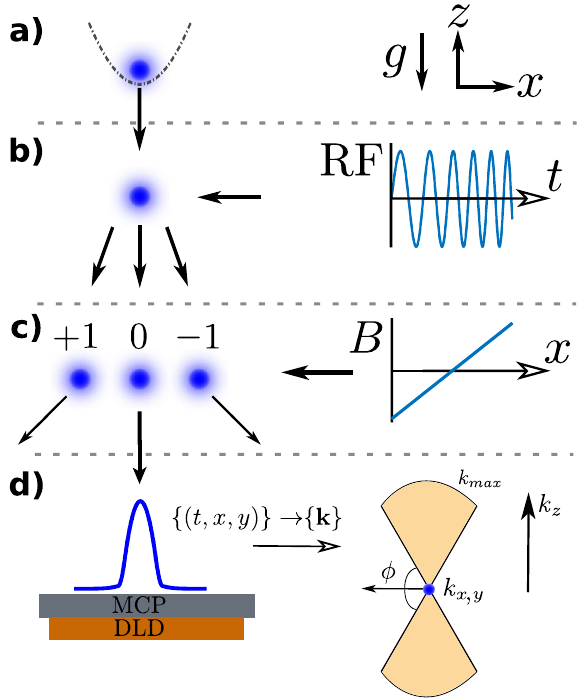
Figure 5. Sketch of the experimental sequence. A BEC is released from a harmonic trap ( a ) and expands during 1, 0, 1 freefall before being split into a superposition of the m J states ( b ) by an RF chirp. A magnetic field ∈ {− } 0 cloud lands on the gradient separates the clouds ( c ) ensuring that only the magnetically insentitive m J = detector ( d ), from which the momentum information is reconstructed. Due to the finite detector radius, the collection region in momentum-space is restricted to two vertically-oriented spherical segments (shaded region) π/ 3 with the horizontal ( x , y ) plane. The quantum depletion lies in the whose boundary subtends an angle φ c = dilute tails at large momentum (cid:31) 6 µ m − 1 (see Fig.